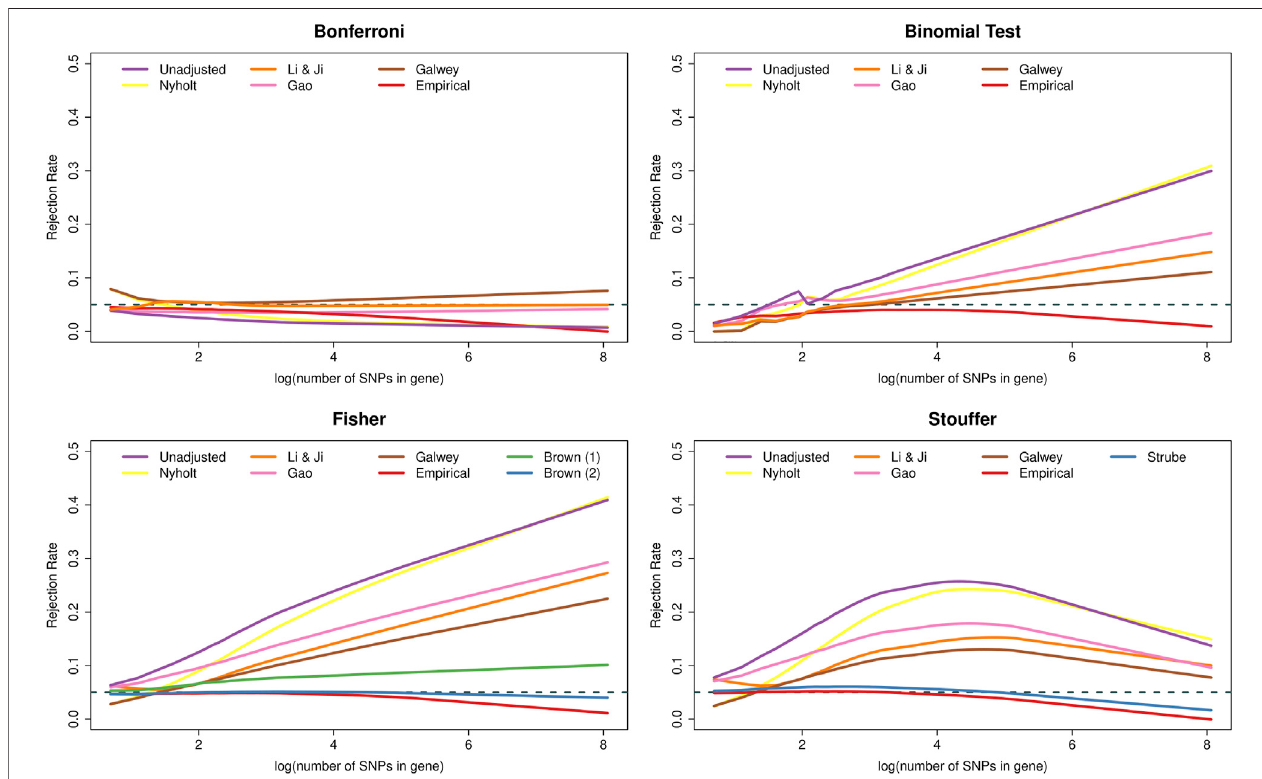
FIGURE 2 | Type I error rates of methods for gene-based testing as a function of the number of SNPs in the genes (log-transformed). The horizontal grey dashed line corresponds to the nominal rejection rate of α = 0.05. Brown (1) and Brown (2) refer to the one- and two-sided versions of Brown ’ s method (i.e., Eqs 13 , 14 ,